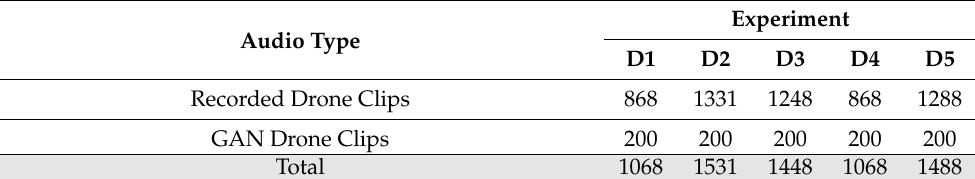
Table 5. RG Drone Audio Dataset Breakdown.